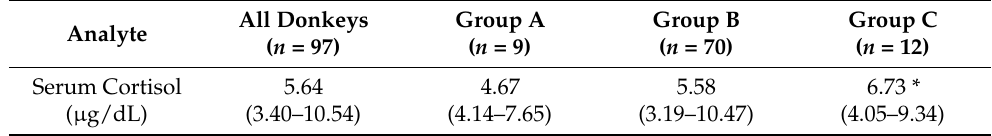
Table 1. Baseline values of cortisol (calculated by median, 2.5th–97.5th percentiles) in all donkeys (females and males), in young and adult females (A and B, respectively), and in pregnant jennies (Group C) expressed in µ g/dL (Conventional Units). To convert µ g/dL to ng/mL values of cortisol must be multiplied by 10. To convert µ g/dL to nmol/L (International System of Units) values of cortisol must be multiplied by 27.59.